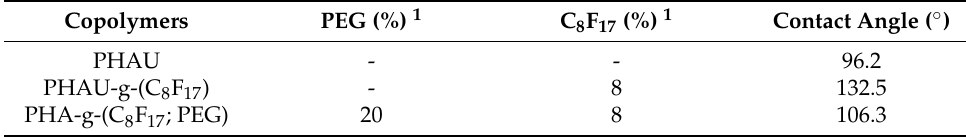
Table 2. Water contact angles and compositions of the different